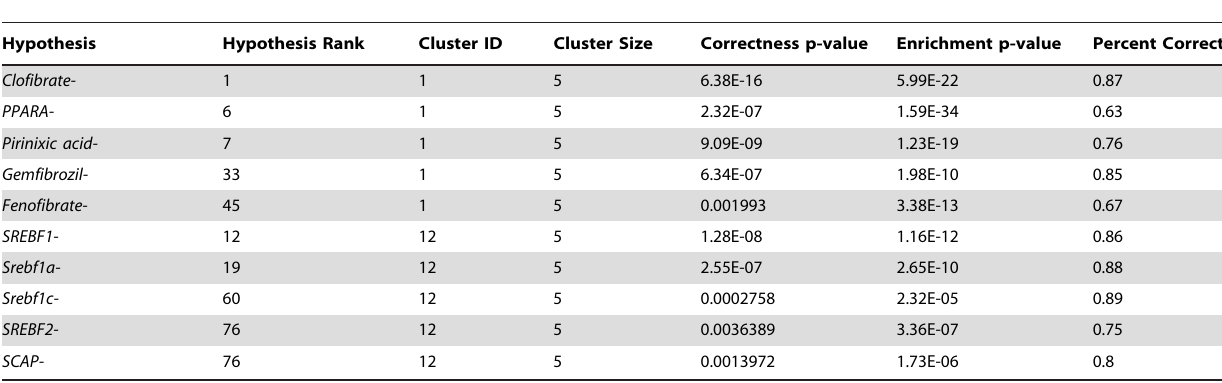
Table 3. Top two clusters for the high dose at cluster threshold